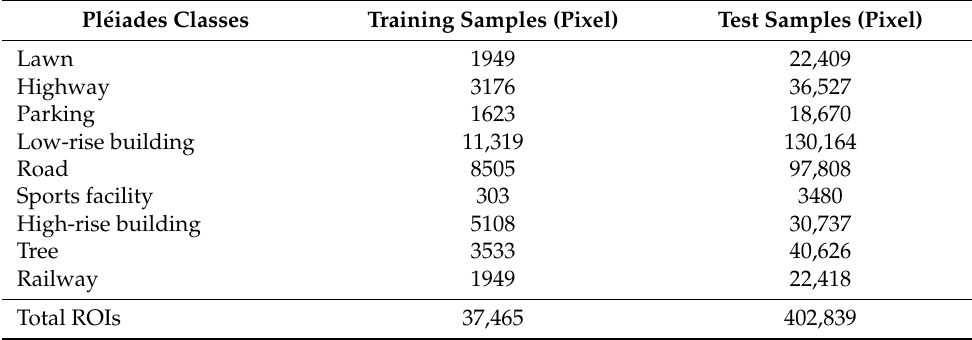
Table A5. Training and test samples for each class in the Melbourne image.